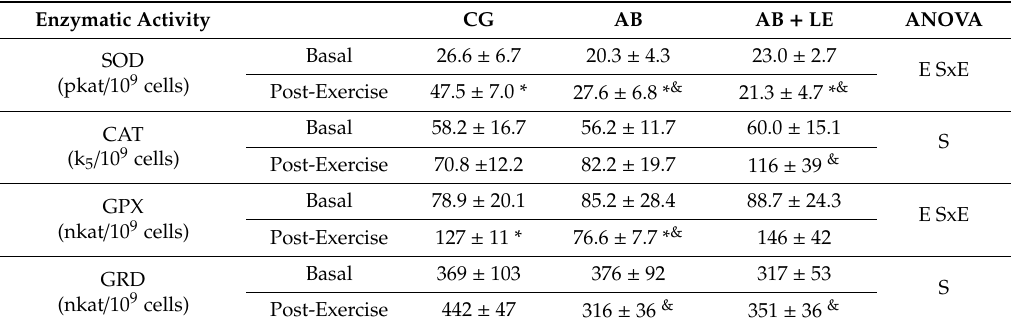
Table 5. Antioxidant enzymatic activities determined in neutrophils in basal conditions and immediately after the 2000-m test in control (CG), almond beverage (AB) and almond beverage + Lippia extract (AB + LE)